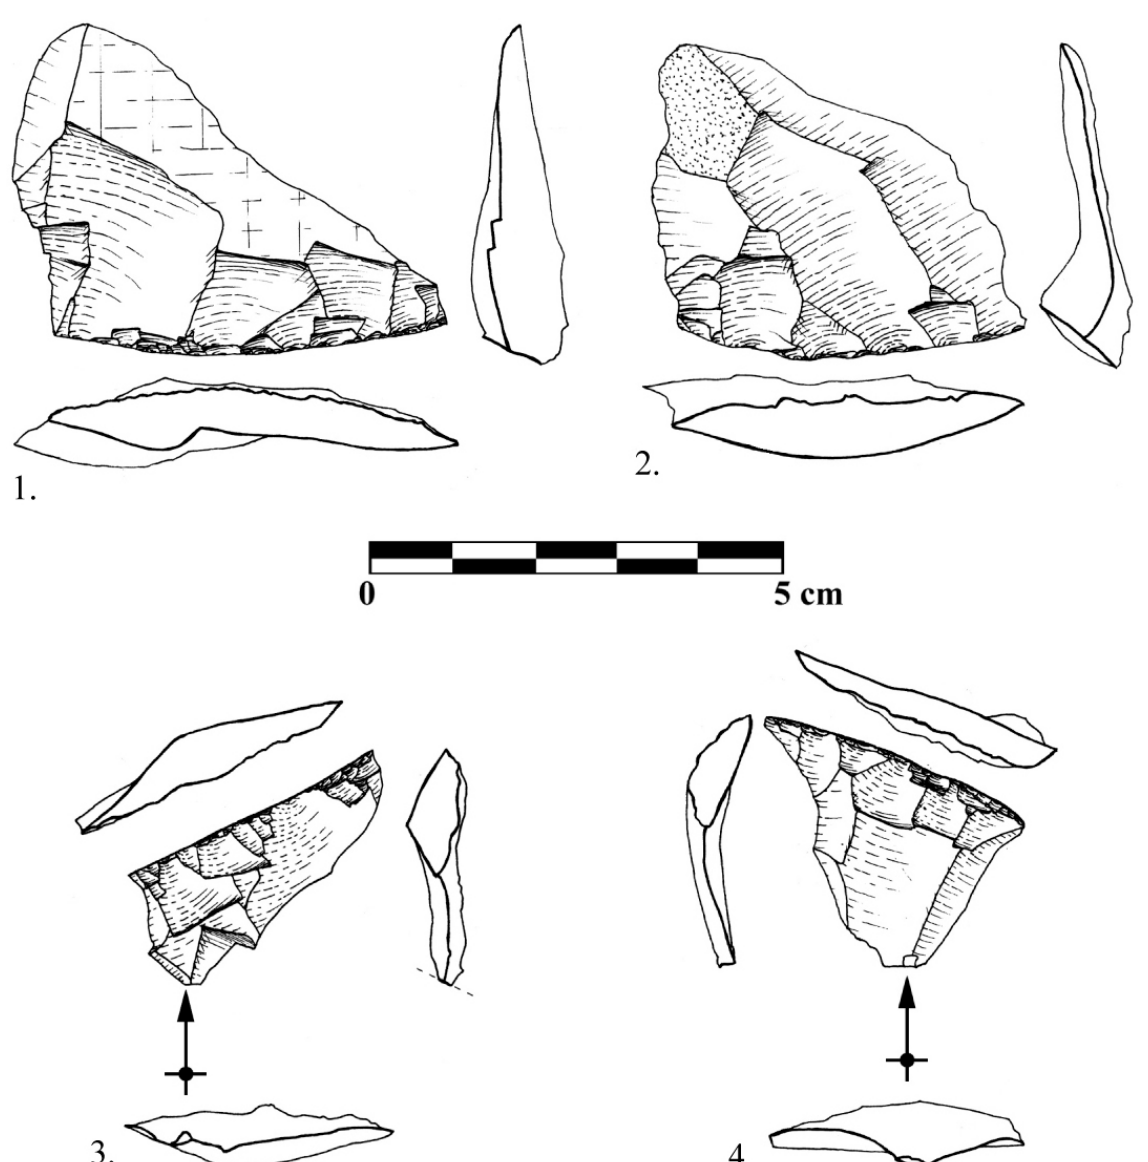
Figure 5. Eclats de raffûtage latéral de pièces façonnées unifacialement. Les pièces 1 et 2 sont détachées par percussion interne depuis la face plane et présentent un lustre d’utilisation identifiable à l’œil nu au niveau de la ligne de séparation entre le talon et la face supérieure. Les pièces 3 et 4 sont détachées par percussion marginale de façon centrifuge, depuis le haut de la face non plane. Figure 5. Lateral resharpening flakes from unifacially shaped artifacts. Artefacts 1 and 2 were removed par internal percussion from the plane surface and present a use luster visible to the naked eye in the line between the butt and the external face. Artefacts 3 and 4 were removed by marginal percussion in a centrifugal direction, from the top of the non-plane